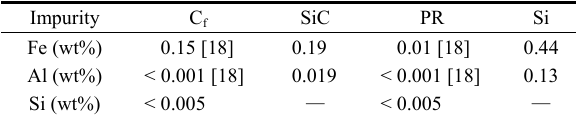
Table 4 Phase compositions of SiC